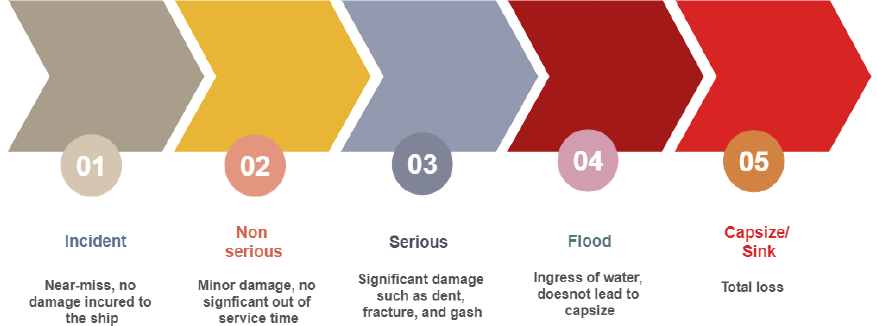
Figure 13. Classification of severity of ship flooding accidents.